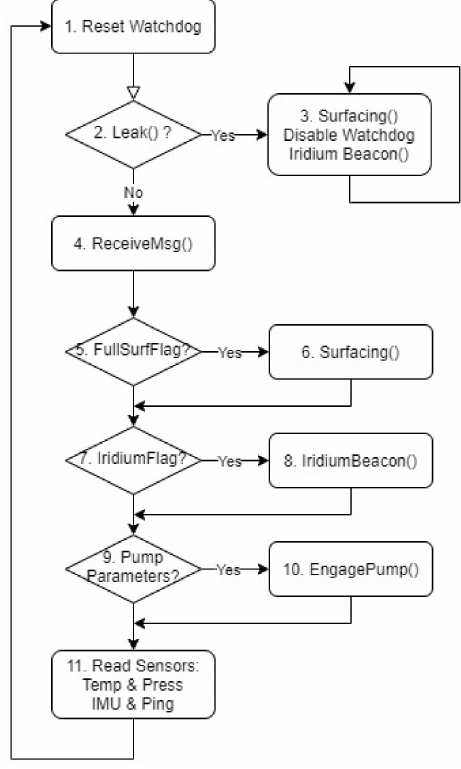
Figure 17. Mega state machine